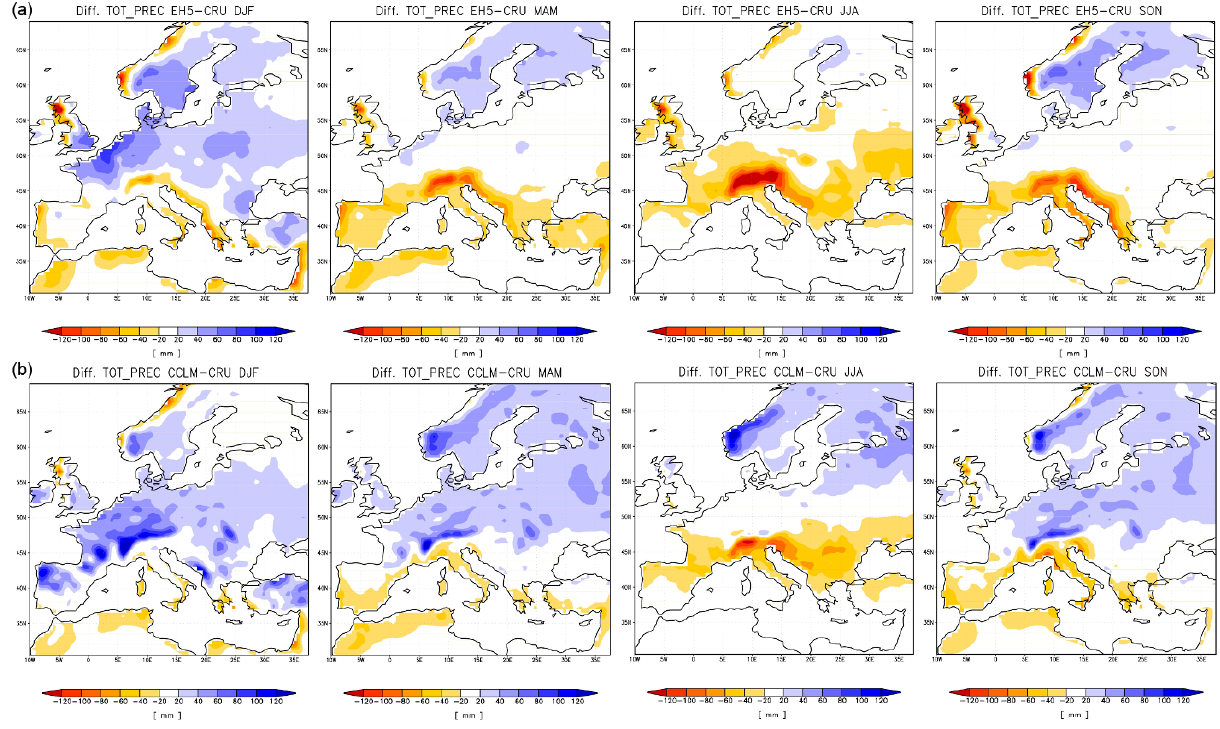
Figure A2. As Fig. A1 but for